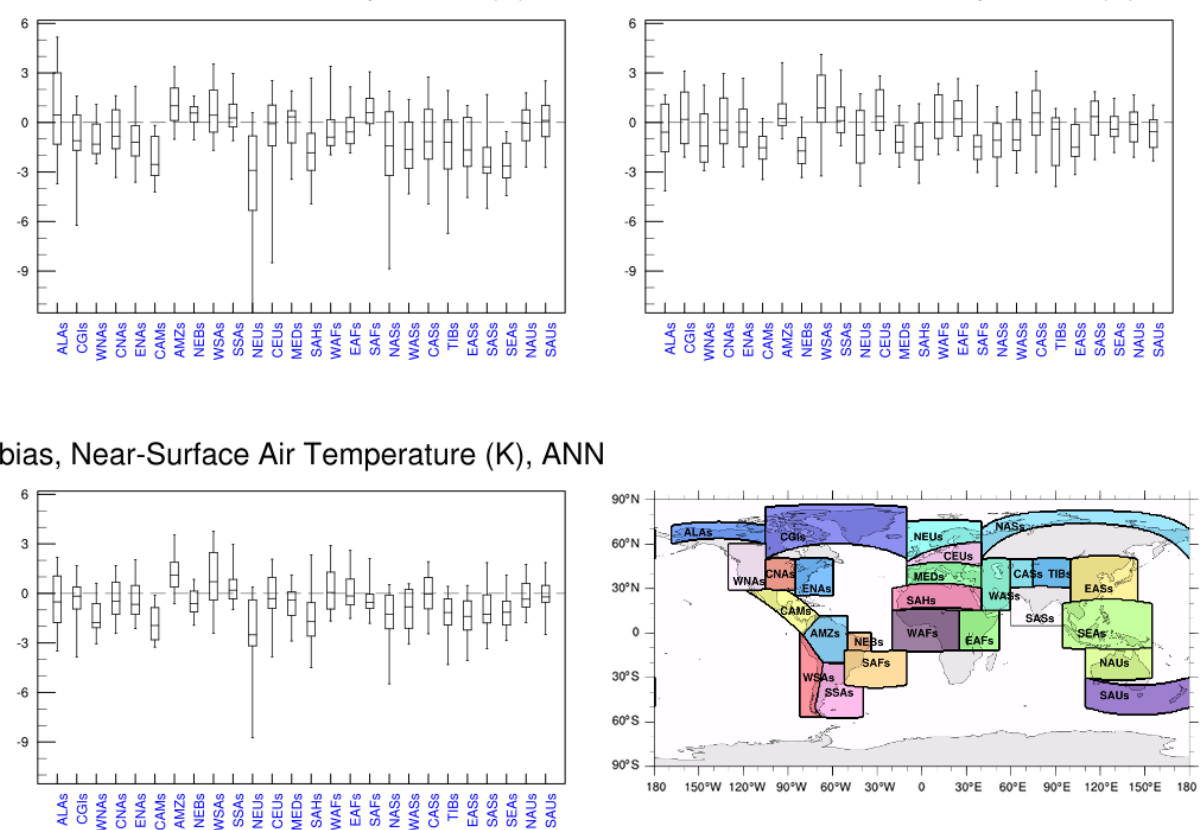
Figure 14. Box-and-whisker plots showing the 5th, 25th, 50th, 75th, and 95th percentiles of the seasonal and annual mean biases for the surface temperature (tas) between 34 CMIP5 models and ERA-Interim data. The regions are as follows: Alaska and NW Canada (ALAs); eastern Canada, Greenland, and Iceland (CGIs); western North America (WNAs); central North America (CNAs); eastern North America (ENAs); Central America and Mexico (CAMs); the Amazon (AMZs); NE Brazil (NEBs); the west coast of South America (WSAs); south- eastern South America (SSAs); northern Europe (NEUs); central Europe (CEUs); southern Europe and the Mediterranean (MEDs); the Sahara (SAHs); western Africa (WAFs); eastern Africa (EAFs); southern Africa (SAFs); northern Asia (NASs); western Asia (WASs); central Asia (CASs); the Tibetan Plateau (TIBs); eastern Asia (EASs); southern Asia (SASs); Southeast Asia (SEAs); northern Australia (NASs); and southern Australia and New Zealand (SAUs). The positions of these regions are shown on the map; they differ from the ones in Fig. 12 and are defined following Seneviratne et al. (2012). Similar to Fig. 9.39a, c, and e of the IPCC AR5 report (Flato et al., 2013) and produced with recipe_flato13ipcc.yml ; for details see Sect.